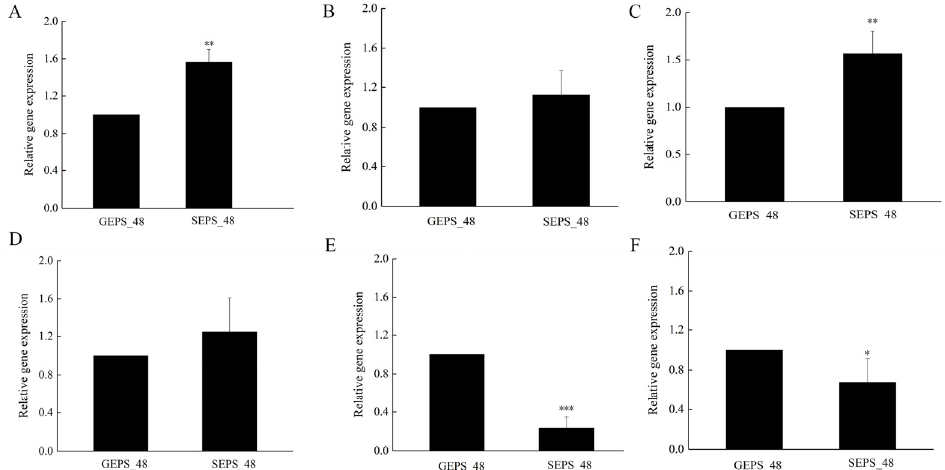
Figure 7. Analysis of relative gene expression level of some identified DEGs. ( A ) pold3 . ( B ) gpt . ( C ) cpsB . ( D ) uap . ( E ) ndk . ( F ) ure . (These values are the mean ± standard deviation of three independent variables. *, p < 0.05. **, p < 0.01. ***, p < 0.001.)